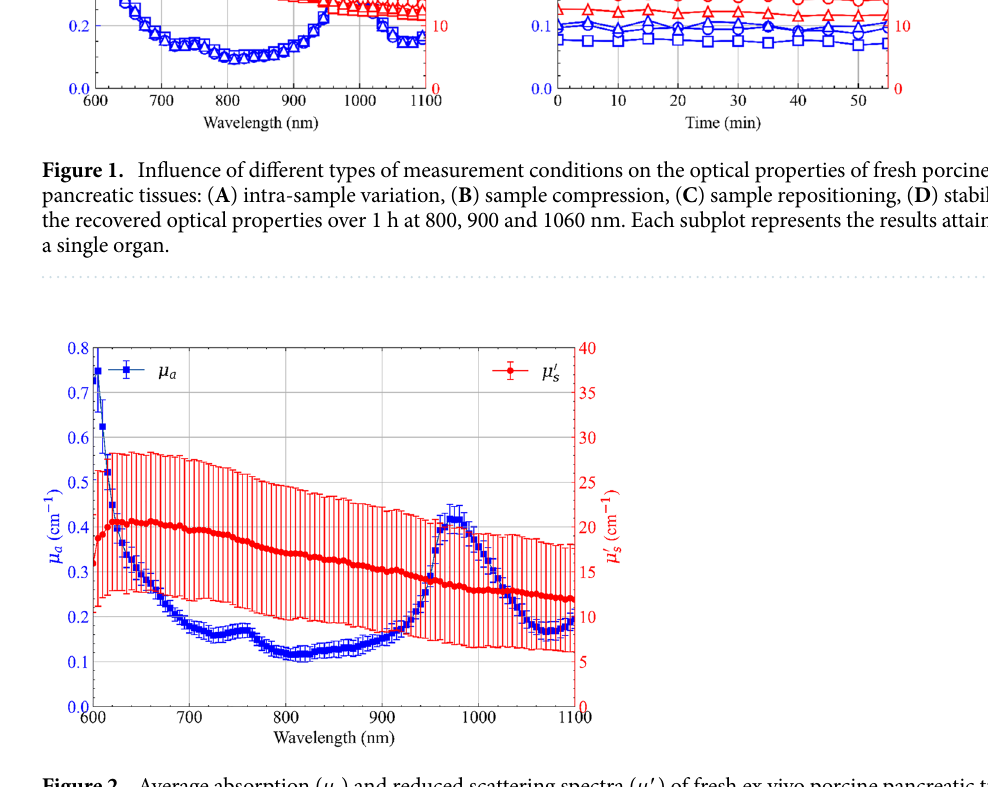
Figure 2. Average absorption ( µ a ) and reduced scattering spectra ( µ ′ s ) of fresh ex vivo porcine pancreatic tissue. Measurements were performed over 5 samples at 3 different positions (A–C) on each sample. The error bars represent the standard deviation over the 15